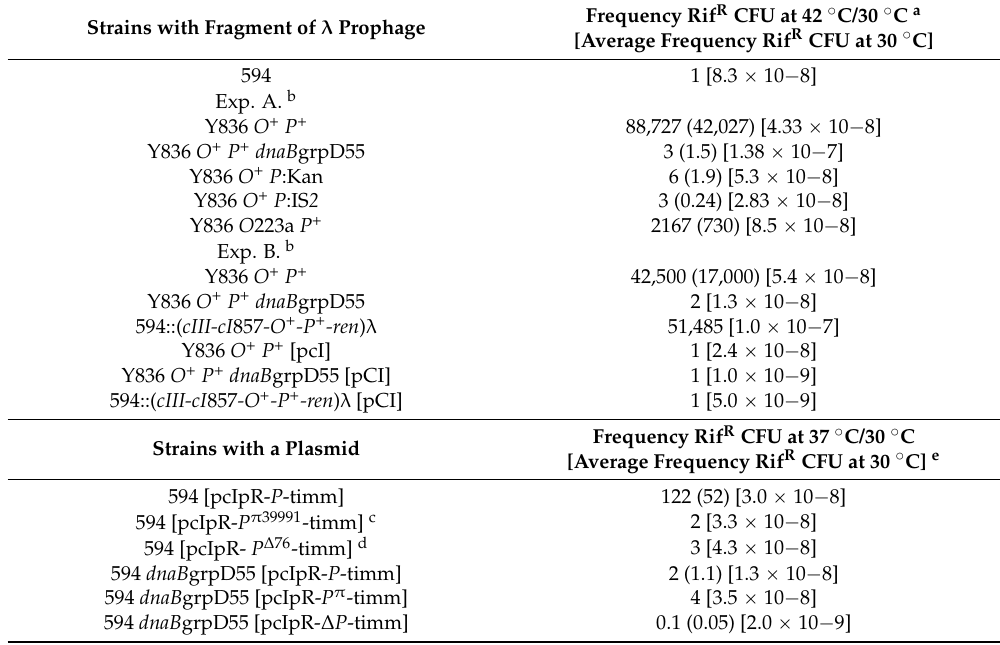
Table 4. Influence of P expression on the selection of rifampicin-resistant (Rif R ) CFU. Strains with Fragment of λ